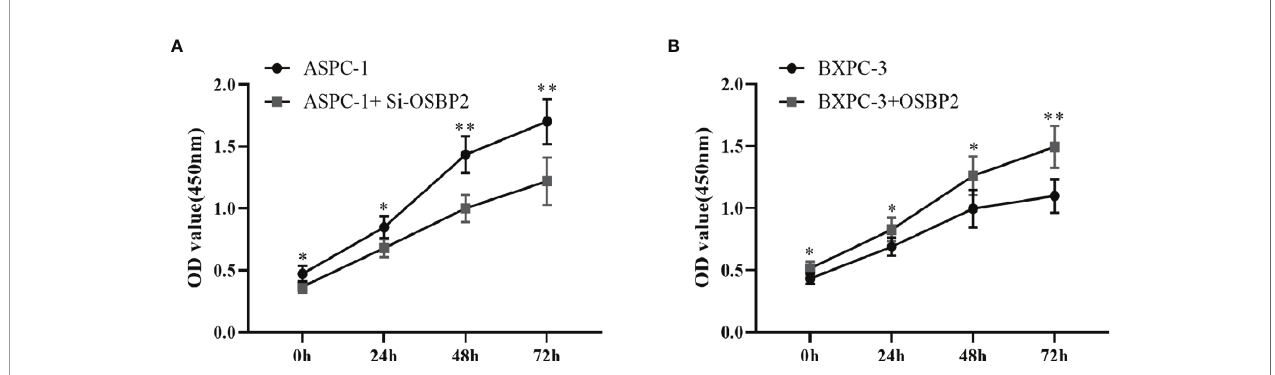
FIGURE 4 | Effect of OSBP2 on PDAC cell proliferation. (A) Low OSBP2 expression decreased tumor cell proliferation in the ASPC-1 cell line (P < 0.01). (B) Overexpression of OSBP2 increased tumor cell proliferation in the BXPC-3 cell line (P < 0.01). OSBP2, oxysterol-binding protein 2; PDAC, pancreatic ductal adenocarcinoma; EV, empty vector. *P < 0.05, **P <